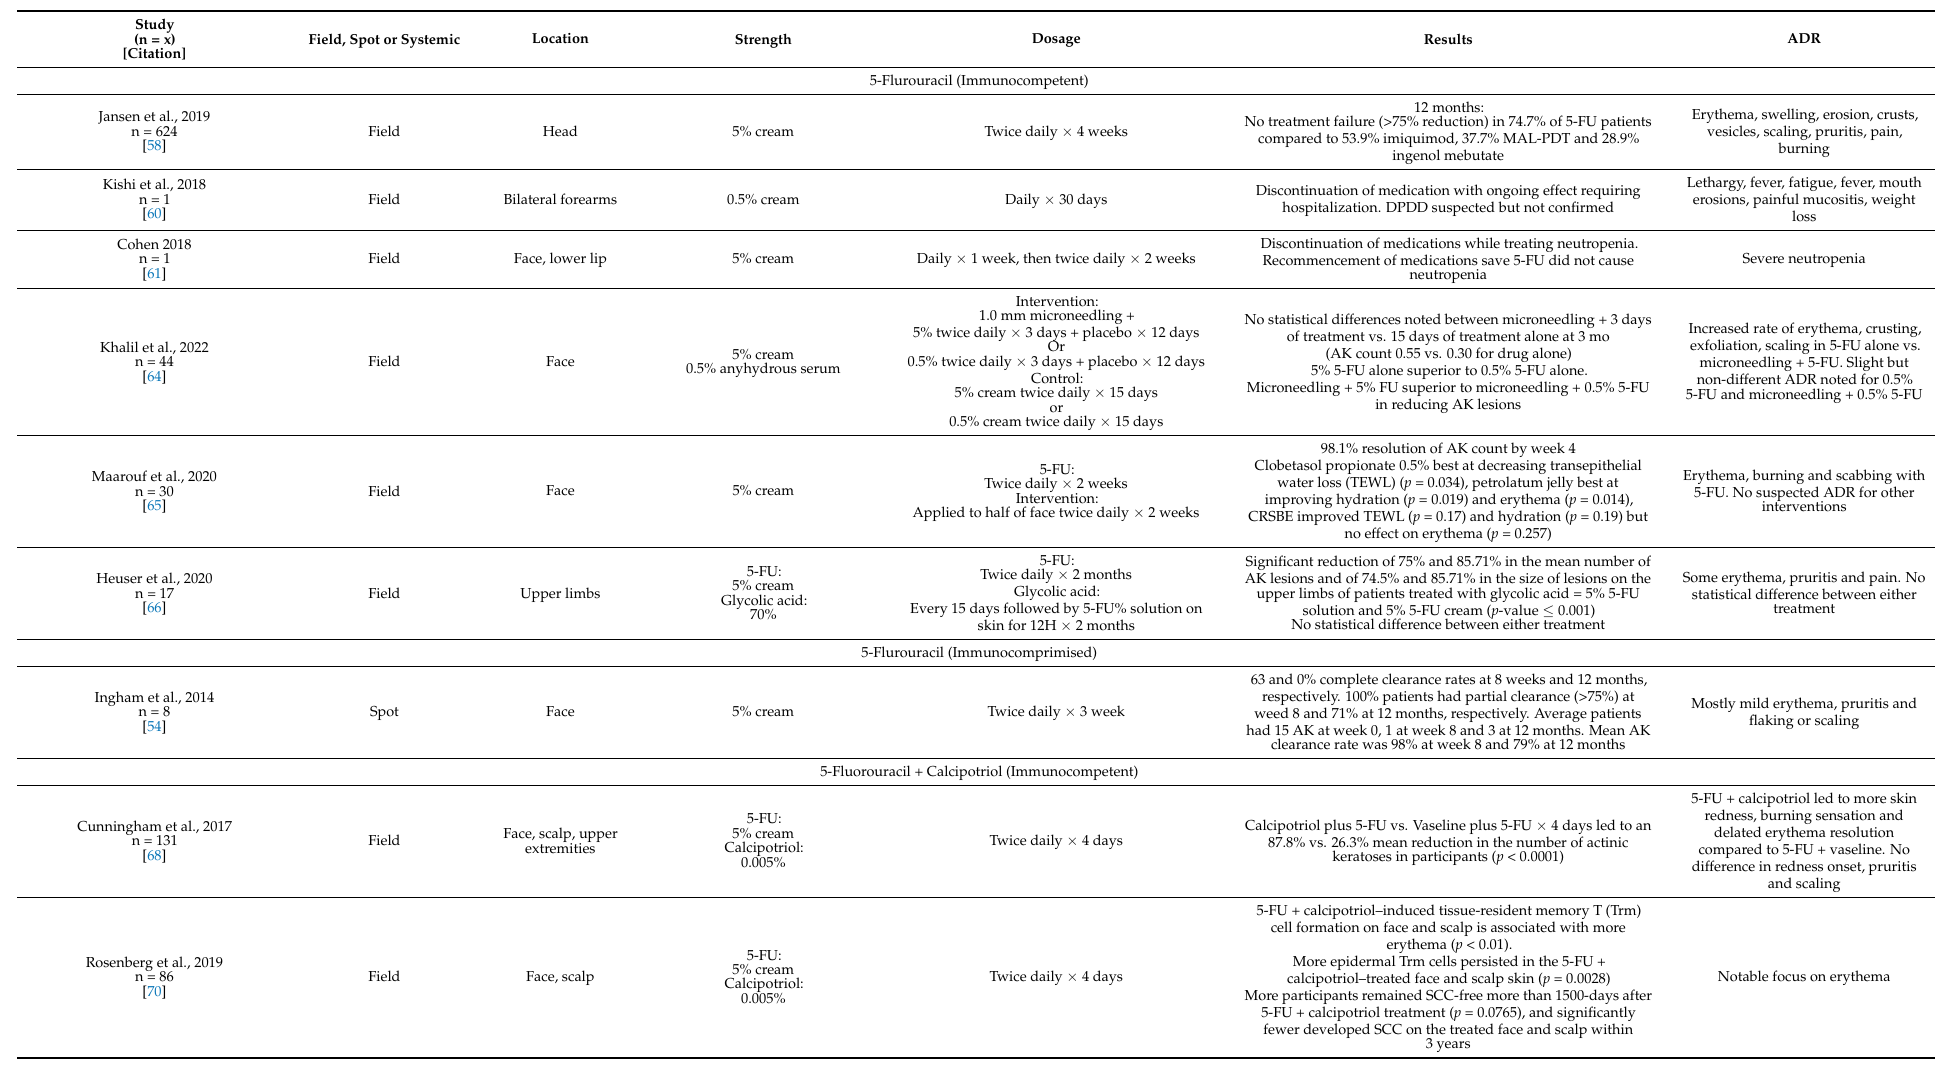
Table 2. Summary of discussed randomized-controlled, case–control and cohort treatment interventions published since